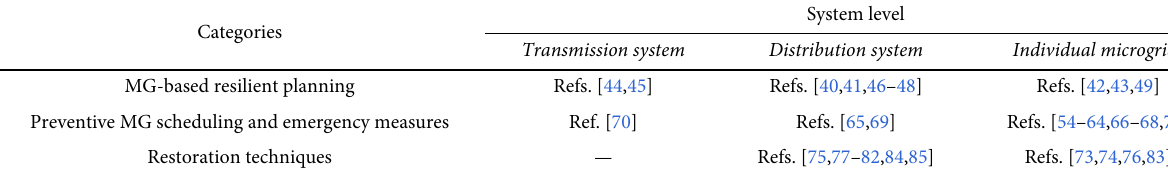
Table 2 Classification of methods according to the system level they are applied to